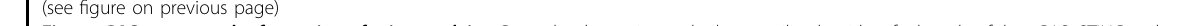
Fig. 1 cGAS prevents the formation of micronuclei. a Generalized experimental scheme utilized to identify the role of the cGAS – STING pathway in the induction of chromosomal instability. b Thirty hours after transfection with the cGAS siRNA, nocodazole treatment (100 ng/mL) commenced for 16h. The mitotic cell fraction was obtained by shaking the plate, and the cells were reseeded on a coverslip; the remaining cells were subjected to western blotting with the indicated antibodies (top panel). Quanti fi cation of the percentage of micronucleated cells was performed by immunocytochemistry (bottom panel) along with representative fl uorescent images showing micronuclei (white arrowhead denotes micronuclei). The results are given as the mean± SD from three independent experiments ( n = 300). *** P < 0.001 as assessed by Student ’ s t -test. c Wild-type HeLa and cGAS − / − HeLa cells were treated with 100ng/mL nocodazole for 16h. Mitotic cells were collected by shaking the plate, and they were then subjected to western blotting (top panel) and immunocytochemical analysis (bottom panel) to quantify micronucleated cells; representative fl uorescent images of micronuclei (white arrowhead denotes micronuclei) are shown. The results are given as the mean± SD from three independent experiments ( n = 300). *** P <0.001 as assessed by Student ’ s t -test. d Cells were co-transfection of sicGAS with a control vector or MYC-cGAS (non-targeting siRNA) in HeLa cells for 20h, and then they were arrested at prometaphase by nocodazole treatment for 16h. Western blotting with the indicated antibodies was performed to con fi rm cGAS knockdown and cGAS add-back (top panel). Immunocytochemistry was performed to evaluate micronucleated cells 10h after release from nocodazole-induced mitotic arrest (bottom panel); representative fl uorescent images show micronuclei (white arrowhead denotes micronuclei). The results are given as the mean±SD from three independent experiments ( n = 300). *** P <0.001 as assessed by Student ’ s t -test. e Transfection of the MYC-cGAS plasmid into cGAS − / − HeLa cells for 12h before the treatment with nocodazole for 16 h. Mitotic cells were collected, reseeded, and cultured for 10 h to quantify the number of cells containing micronuclei by immunocytochemistry (bottom panel); representative fl uorescent images show micronuclei (white arrowhead denotes micronuclei), and their cell lysates were used for western blotting with the indicated antibodies (top panel). The results are given as the mean±SD from three independent experiments ( n = 300). *** P <0.001 as assessed by Student ’ s t -test. f U2OS cells were transfected with sicGAS for 30h after pretreatment with nocodazole for 16h. Mitotic cells were subjected to western blotting to determine cGAS and GAPDH (loading control) protein levels (top panel) as well as ICC to enumerate the percentage of cells with micronuclei (bottom panel); representative fl uorescent images show micronuclei (white arrowhead denotes micronuclei). The results are given as the mean± SD from three independent experiments ( n = 300). *** P < 0.001 as assessed by Student ’ s t